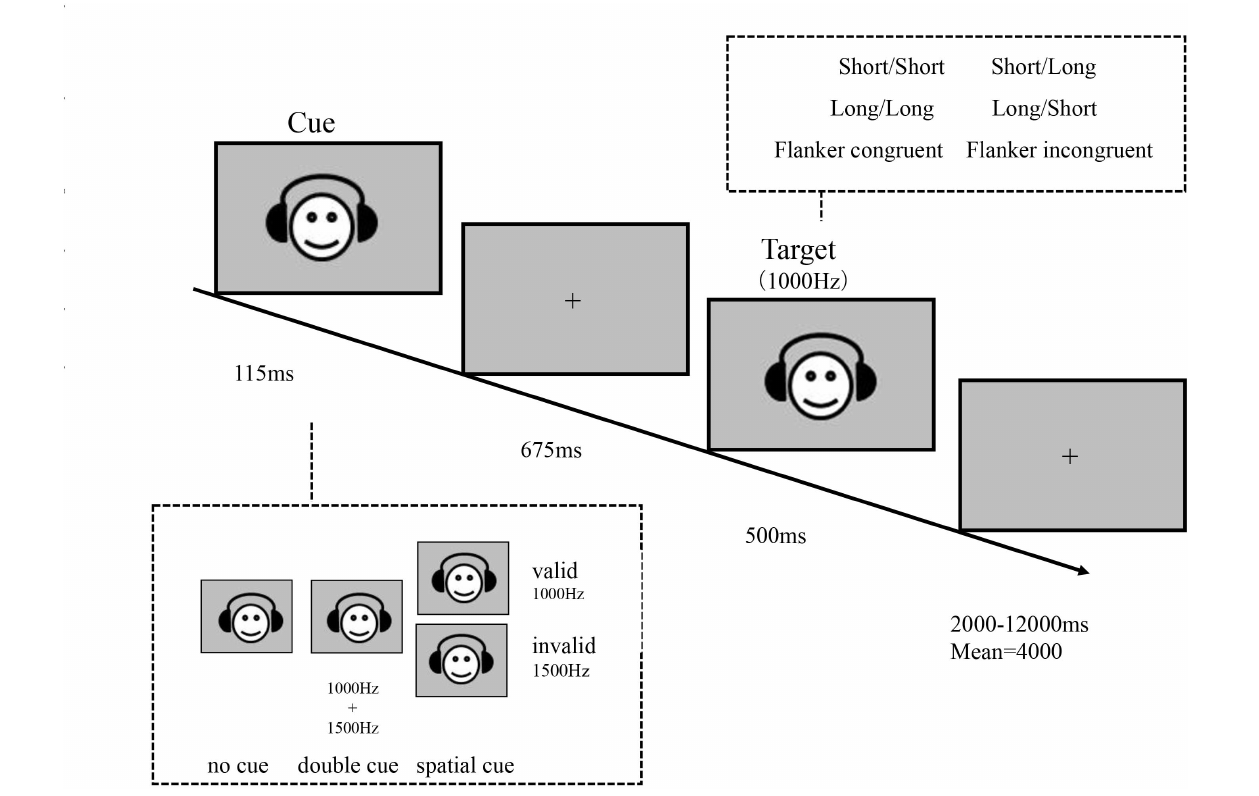
FIGURE 2 | Schematic of the auditory attention network task (ANT-A).